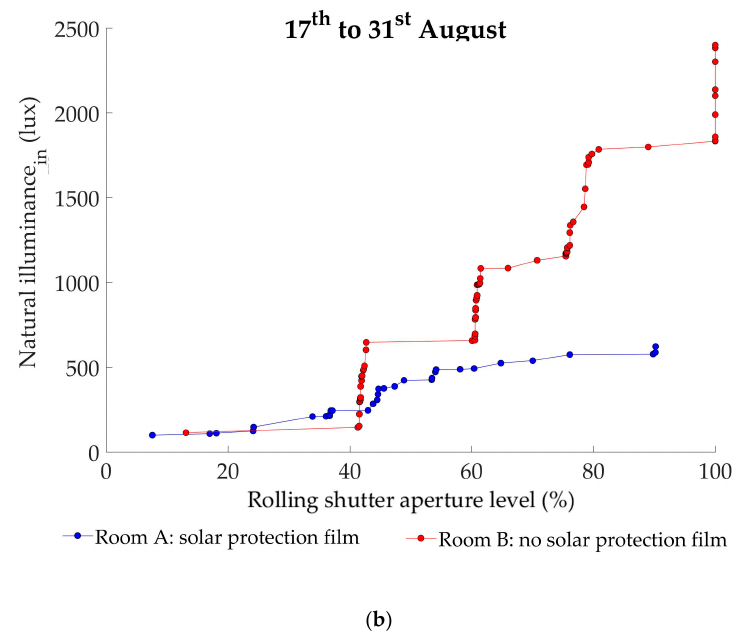
Figure 5. Summer period: ( a ) Outdoor and indoor natural illuminance; ( b ) Cumulative distribution of rolling shutter aperture levels (%) and indoor natural illuminance. Source: Authors.